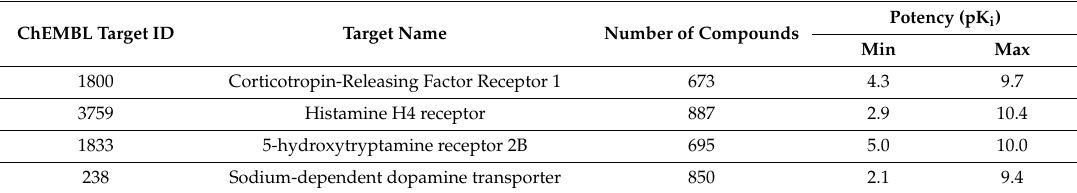
Table 1. Datasets. The table summarizes the composition of four exemplary compound datasets (di ff erent activity classes) used for 3D AL analysis.